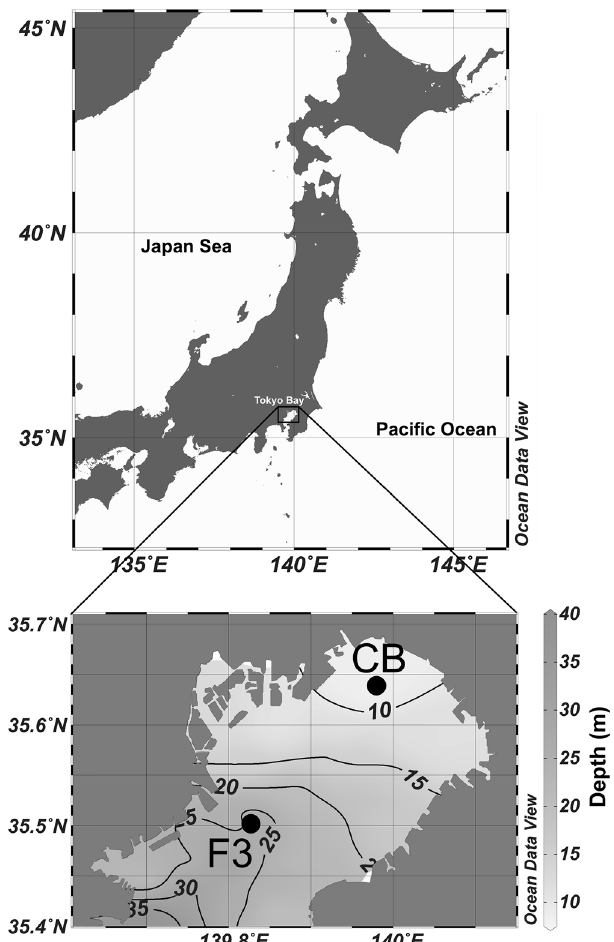
Figure 1. Location of the sampling station: St. F3 and St. CB in Tokyo Bay (St. F3: 35° 30 ′ 30 ″ N, 139° 50 ′ 00 ″ E) (St. CB: 35° 38 ′ 00 ″ N, 139° 58 ′ 00 ″ E). Lines indicate bathymetric contours. Maps were drawn using ODV version 5.0.0 (Schlitzer, Reiner, Ocean Data View, 2020, https:// odv. awi. de/). Bathymetric data were obtained from Ministry of Land, Infrastructure, Transport and Tourism (https:// www1. kaiho. mlit. go. jp/ KAN3/ kaisyo/ tokyo_ kankyo/ htm/ kakod ata.